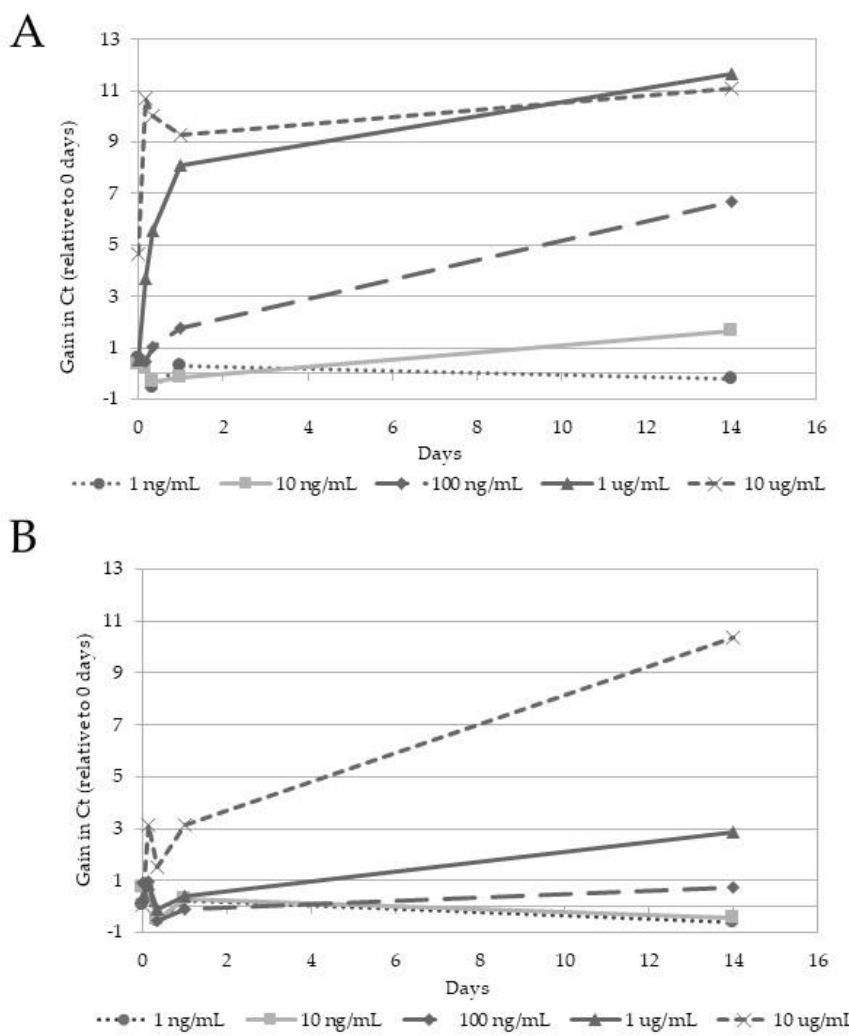
Figure 1. SARS-CoV-2 RNA stability of swab samples in SSB-4M in the presence of RNase A. RNA was isolated from samples in SSB-4M diluted to 1:1 with 0.9% NaCl ( A ) or undiluted SSB-4M ( B ) spiked with SARS-CoV-2 viral particles. Different concentrations of RNase A were added as indicated, and the presence of SARS-CoV-2 RNA was measured at five different points in time (0, 4, 8, 24 h and 14 days post-RNAse A spiking). The relative gain of Ct is shown over time. Table 3. Comparison of two RNA extraction and RT-qPCR methods regarding the detection of SARS-CoV-2-positive samples stored in SSB-4M. Naso- and oropharyngeal swabs and pharyngeal lavage of 16 previously SARS-CoV-2-positive individuals were compared by applying our in-house RNA extraction and RT-qPCR, as well as nucleic acid extraction and RT-qPCR with the Cobas 8800 test system from Roche Diagnostics. Presented data show the number of correctly identified SARS-CoV-2-positive samples out of 16 samples investigated in